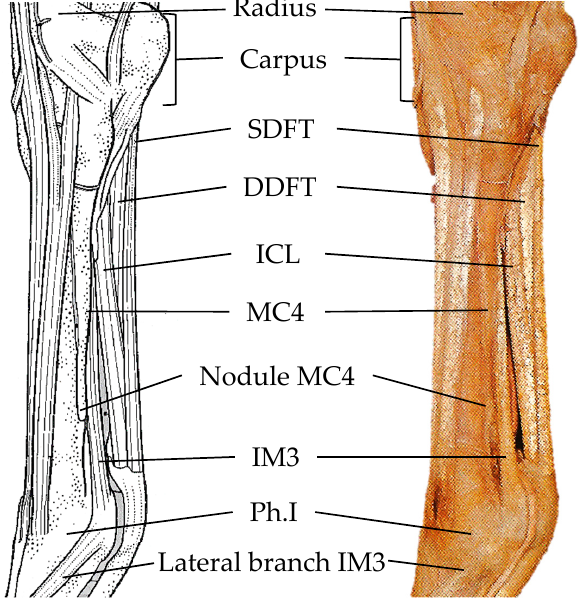
Figure 2. Left foreleg: the lateral view of the carpus, metacarpal III, metacarpophalangeal joint and proximal phalanx I with major soft tissue structures. Adapted from Ashdown and Done [20]. SDFT: flexor digitorum superficialis, DDFT: flexor digitorum profundus, ICL: profundus ligamentum accessorium or inferior check ligament, MC4: metacarpal IV, IM3: interosseous muscle III.